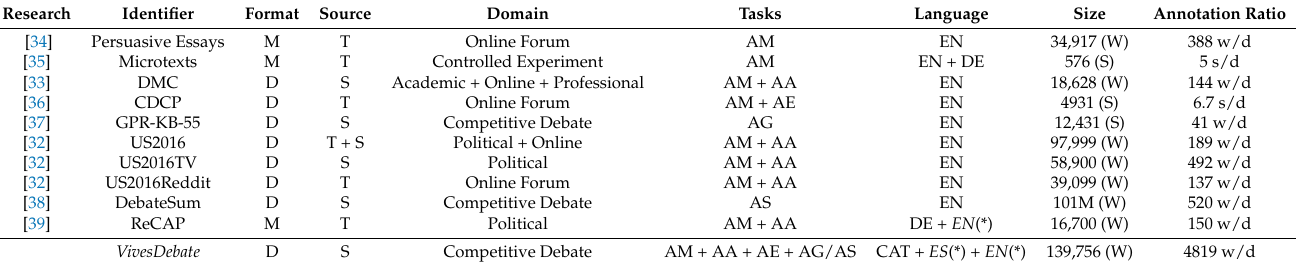
Table 5. Comparison of computational argumentation corpora. (*) Automatically translated